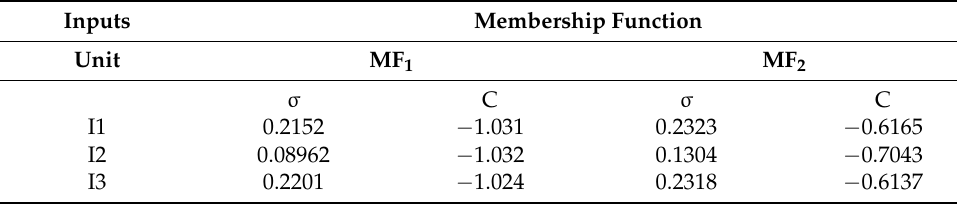
Table 3. List of constant values.